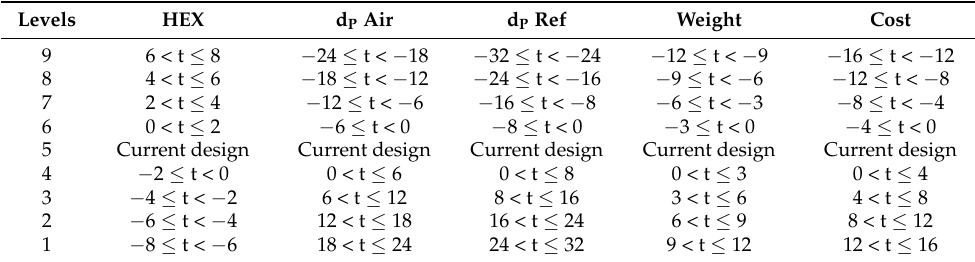
Table 3. Rating levels to evaluate concept